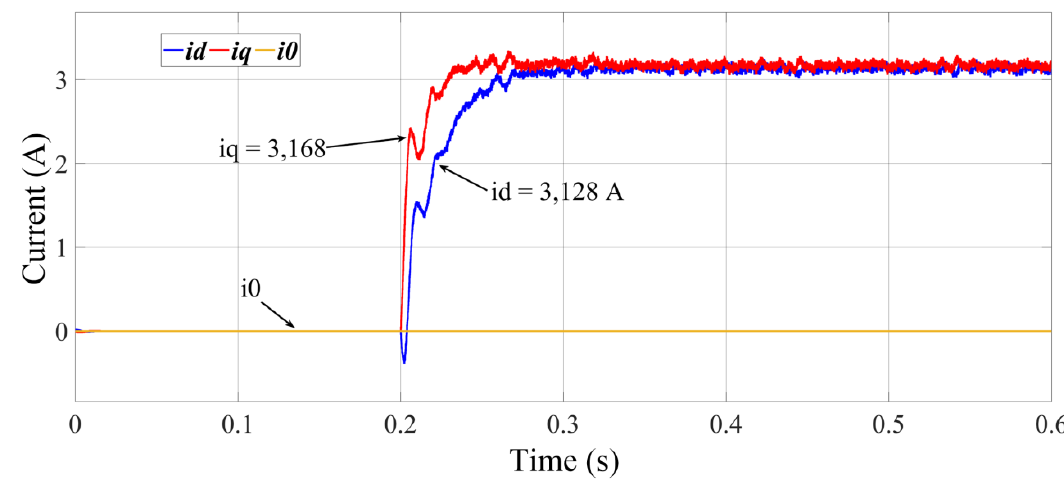
Figure 14. Direct axis current (blue) and quadrature axis current (red) measured at HV of system to F p = 0.7. Vertical axis: 1 A / div. Horizontal axis: 100 ms /